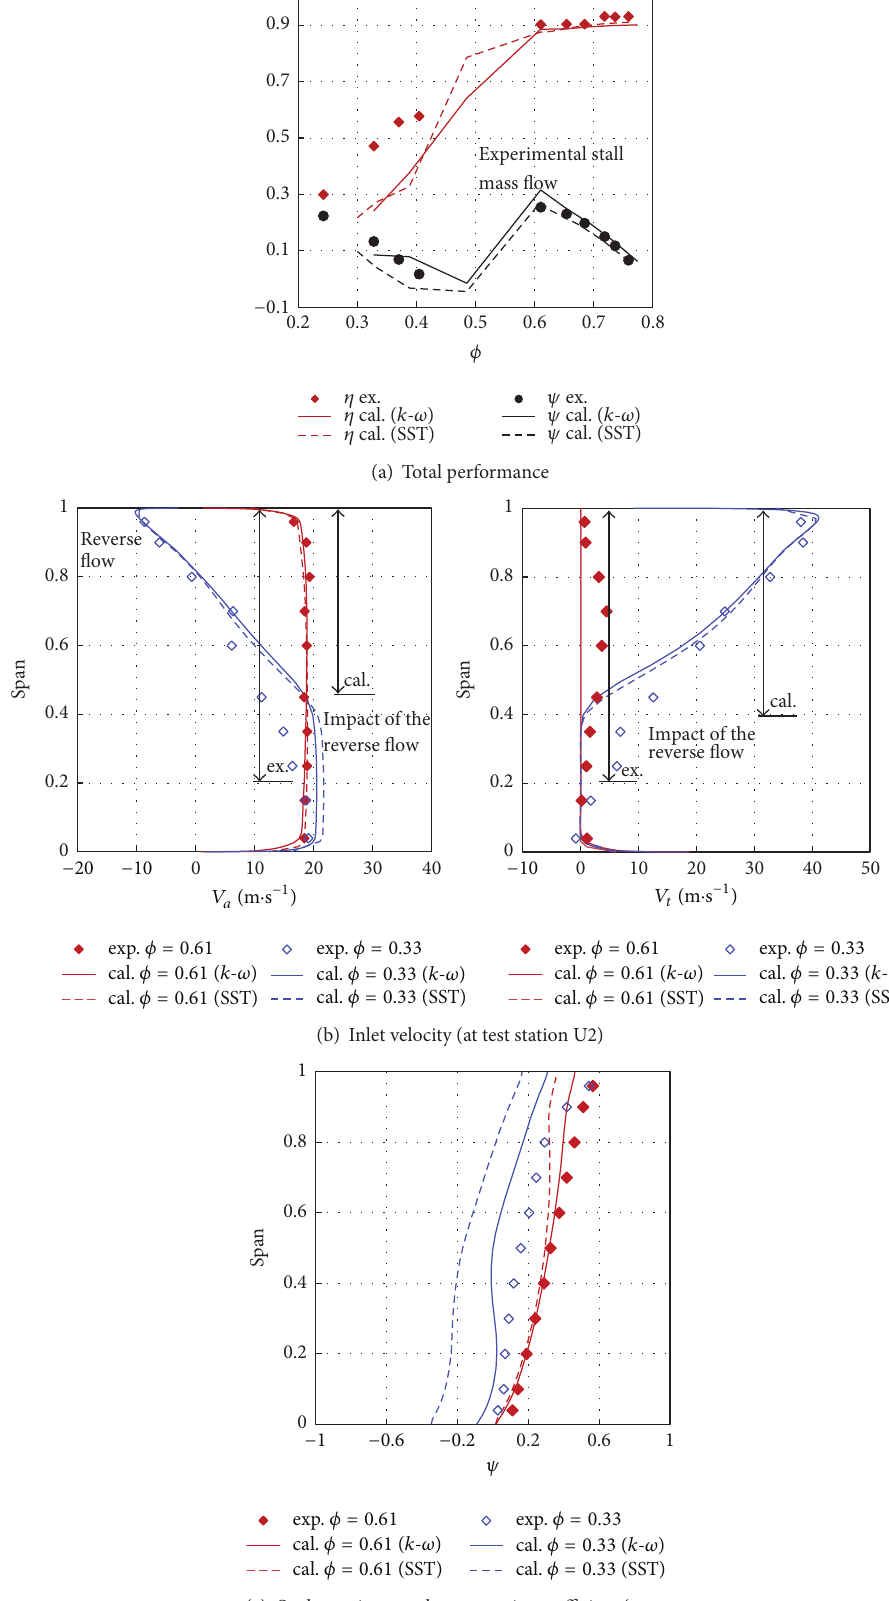
Figure 2: Comparison between simulation results and experiment data